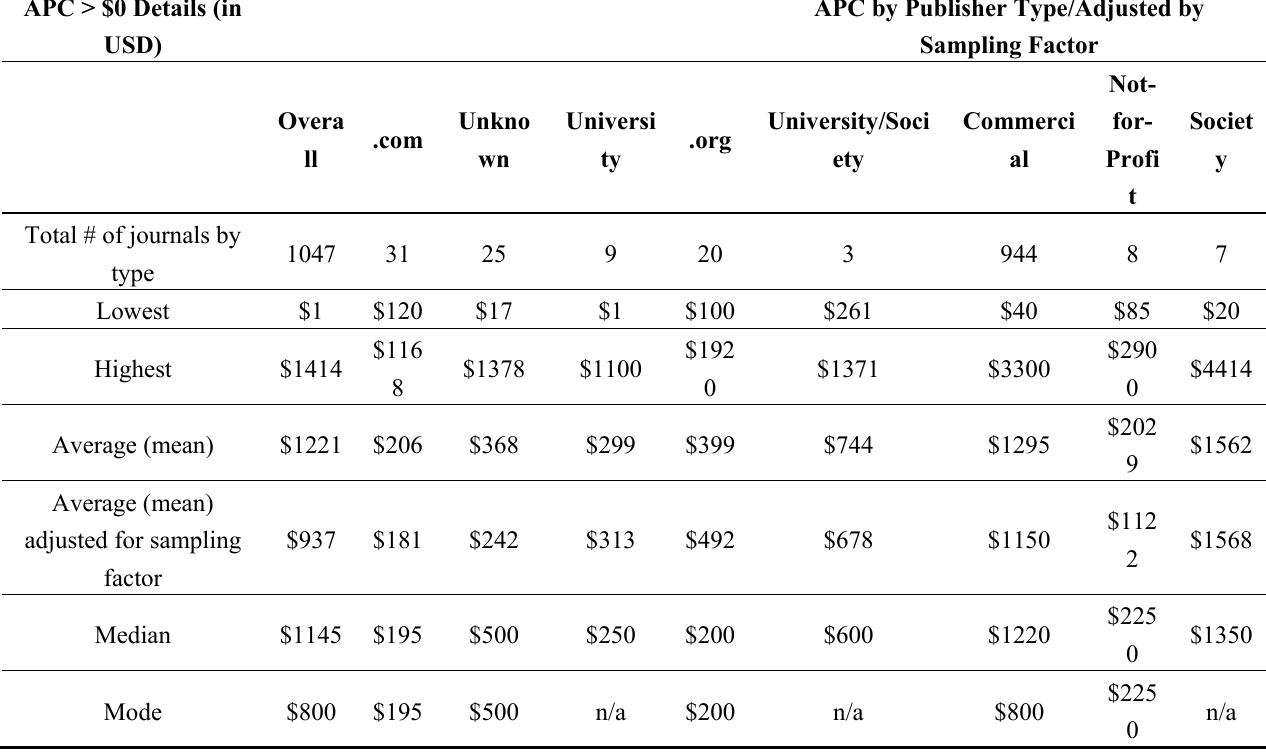
Table 5. APC by publisher type.